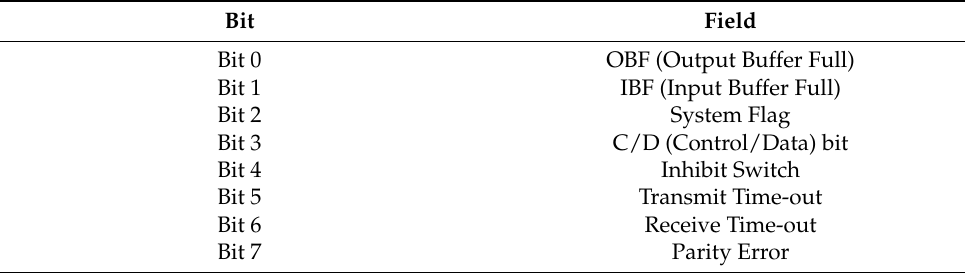
Table 2. Keyboard-status register configuration.